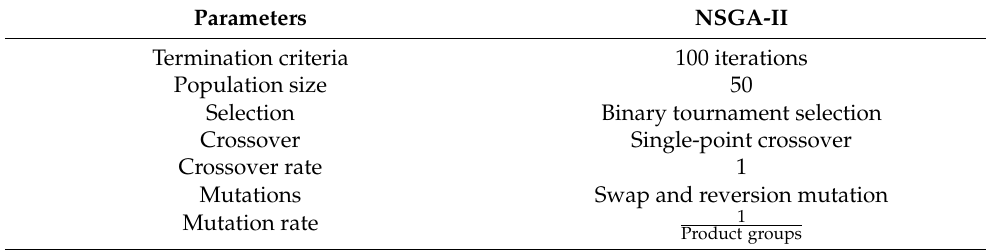
Figure 10. ( a ) Swap mutation and ( b ) reversion mutation for the same solution with two random points, 2 and 5. Table 2. Parameter settings for NSGA-II.